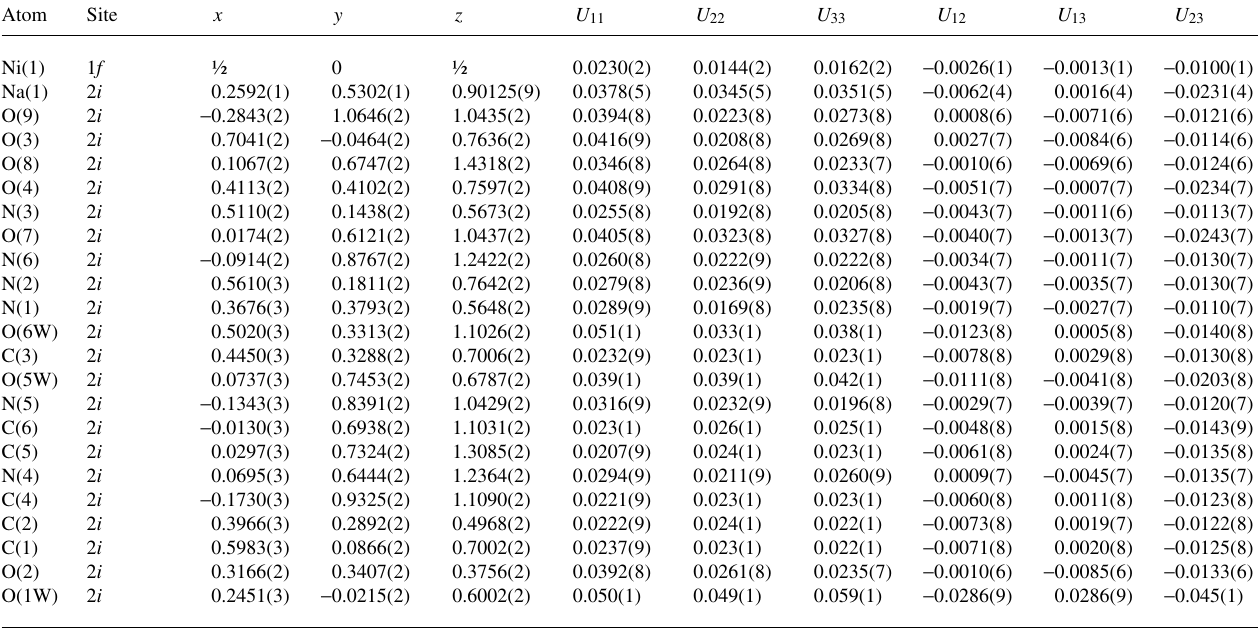
Table 3. Atomic coordinates and displacement parameters (in Å 2 )